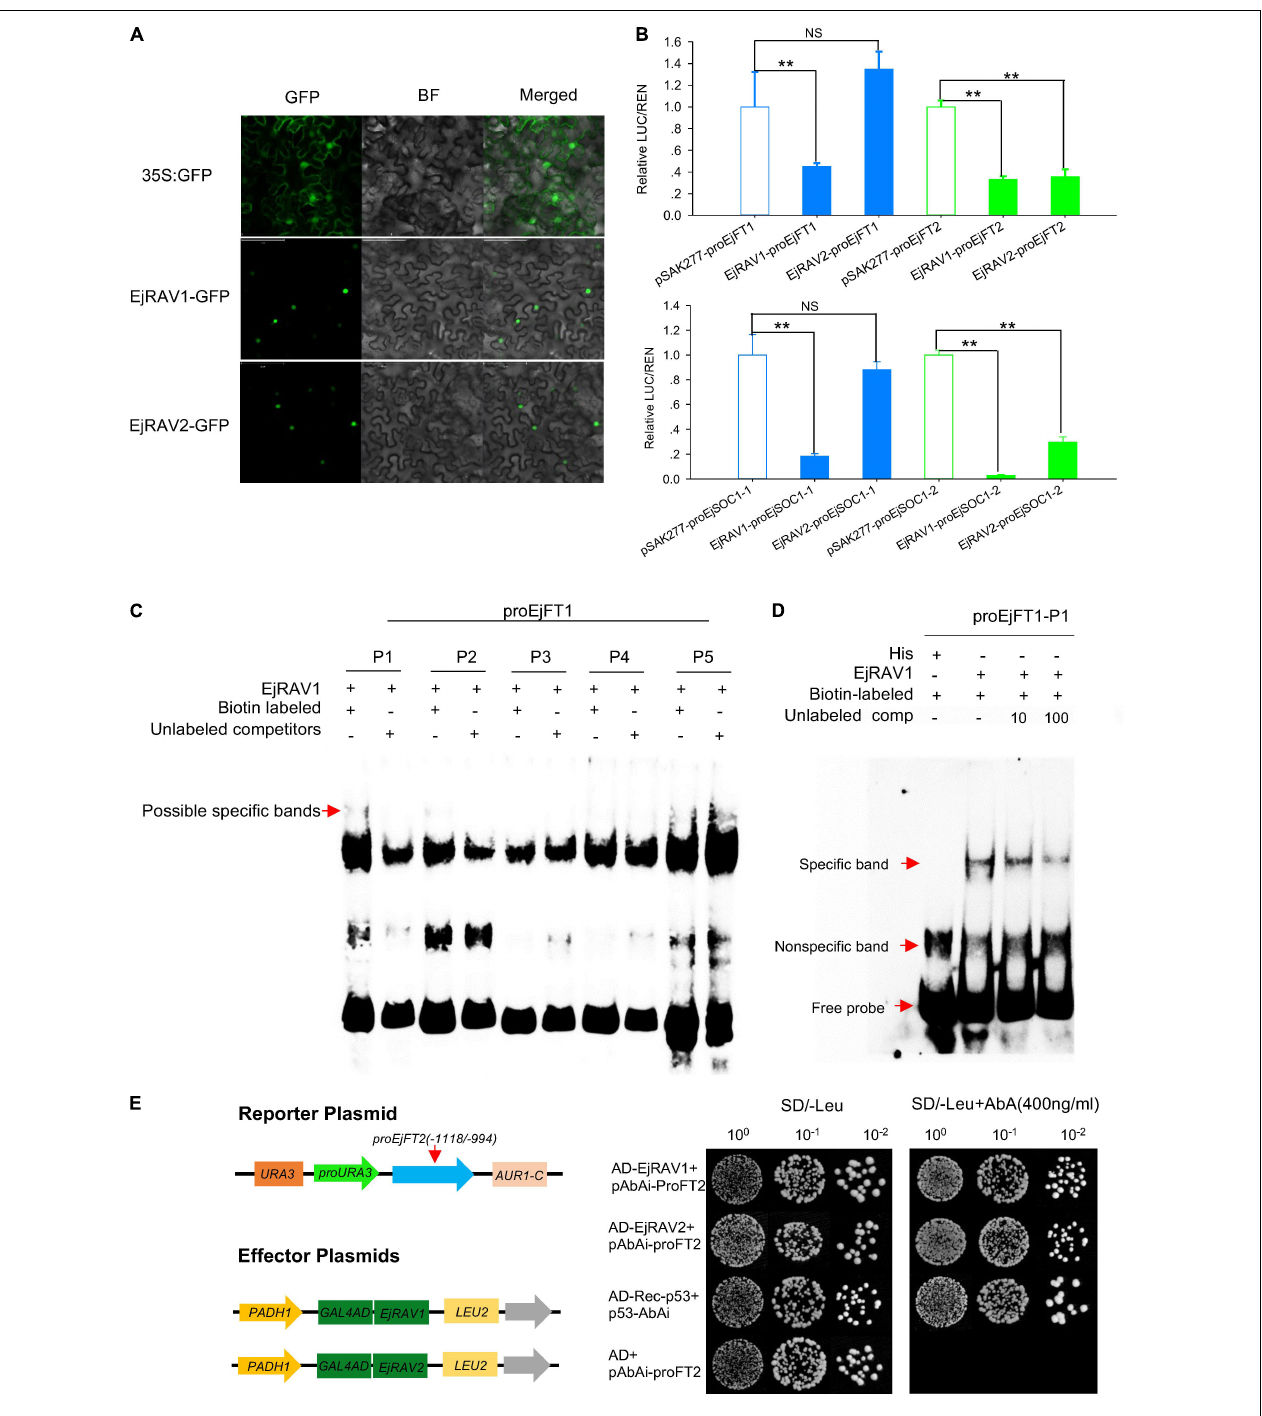
FIGURE 5 | Protein localization, binding and regulation abilities of EjRAVs on FT and SOC1 homologs in loquat. (A) Subcellular localization of EjRAV1/2 proteins expressed in tobacco epidermal cells. (B) EjRAV1/2 regulation on EjFT s and EjSOC1 s expressions in N. benthamiana leaves by using the dual-luciferase (LUC) system. Relative renilla (REN) luciferase activity was used as an internal control. Data represent means ± standard error from three replicates. ** P < 0.01 and NS indicate significance and non-significance, respectively. (C,D) Binding ability of EjRAV1 to P1 of EjFT1 promoter in EMSA assays. P1, P2, P3, P4, and P5 are presumptive RAV protein binding sites on promoter of EjFT1 at ( − 1583 to − 1579 bp), ( − 1059 to − 1054 bp), ( − 1033 to − 1029 bp), ( − 782 to − 778 bp), and ( − 73 to − 66 bp). Unlabeled probe could reduce binding ability of EjRAV1 to P1 in (D) . (E) Binding ability of EjRAV1 and EjRAV2 to segment3 ( − 1118 to − 994 bp) of EjFT2 promoter in Y1H